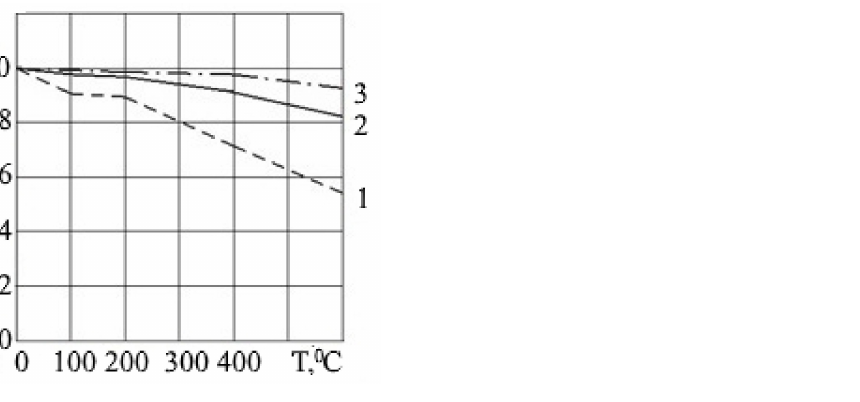
Figure 9. Dependence of the decrease in material strength on temperature: 1—glass fiber; 2—basalt fiber; 3—fiber with the addition of